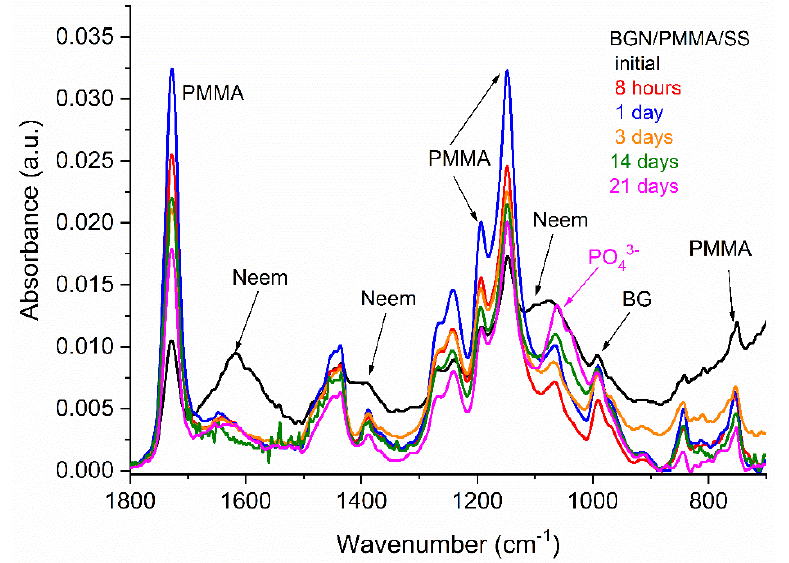
Figure 9. FTIR spectra of the initial and immersed samples for different time, respectively.